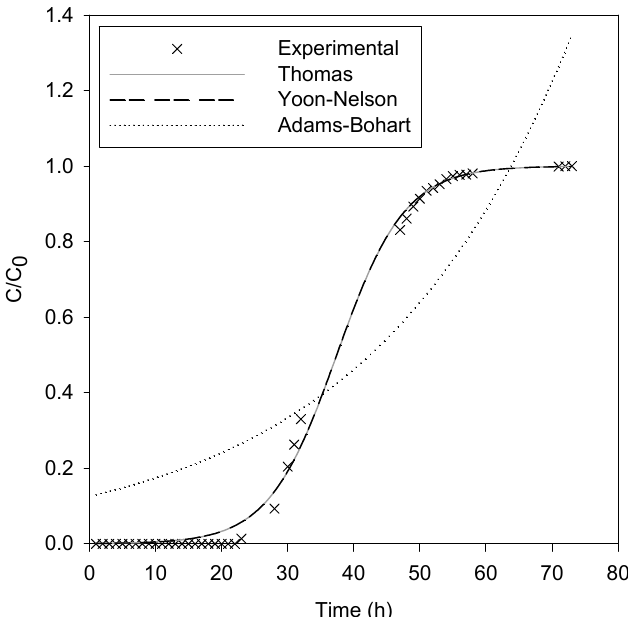
Figure 2. Experimental data obtained in the breakthrough study of the [bpy] Cl-S-Fe system and fitting of the experimental breakthrough data to mathematical models. Operational conditions: fresh [bpy] Cl solution concentration = 200 mg L − 1 ; column height = 14 cm; flow rate = 1.52 mL min − 1 .